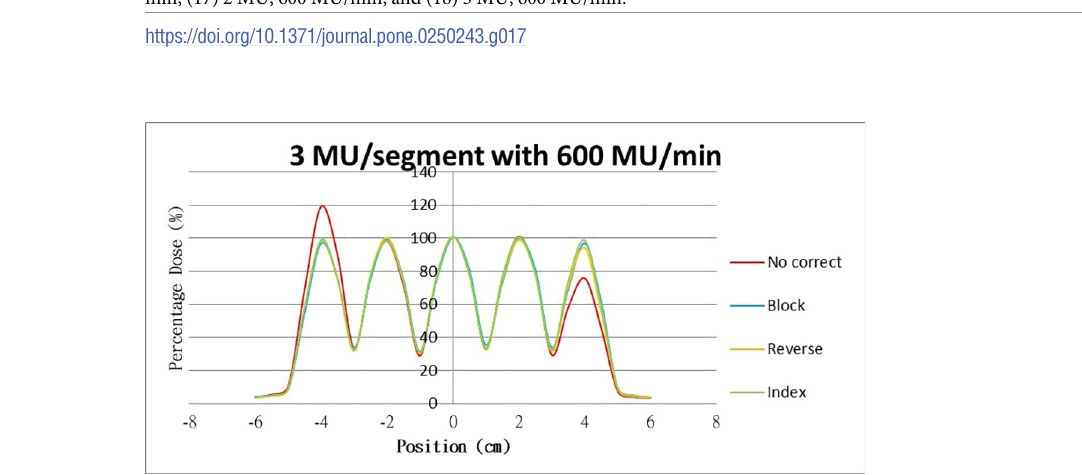
Fig 17. Relative doses for overshoot after the three corrections were applied. Relative doses at (16) 1 MU, 600 MU/ min; (17) 2 MU, 600 MU/min; and (18) 3 MU, 600 MU/min.